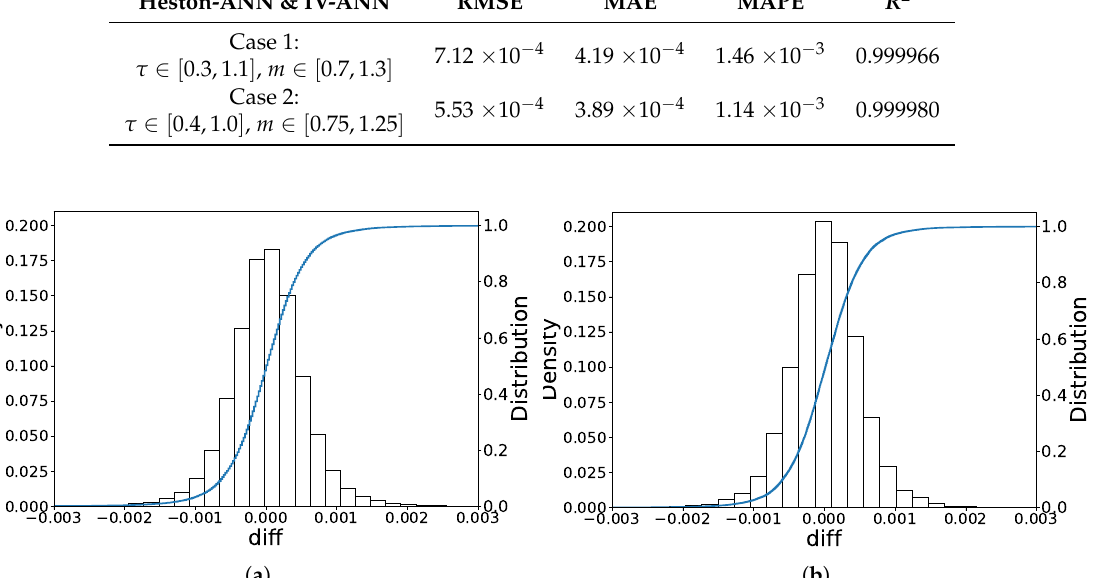
Figure 11. The error distribution of the implied volatility: The combined Heston-ANN and IV-ANN techniques for implied volatility. ( a ) Case 1: The error distribution; ( b ) Case 2: The error